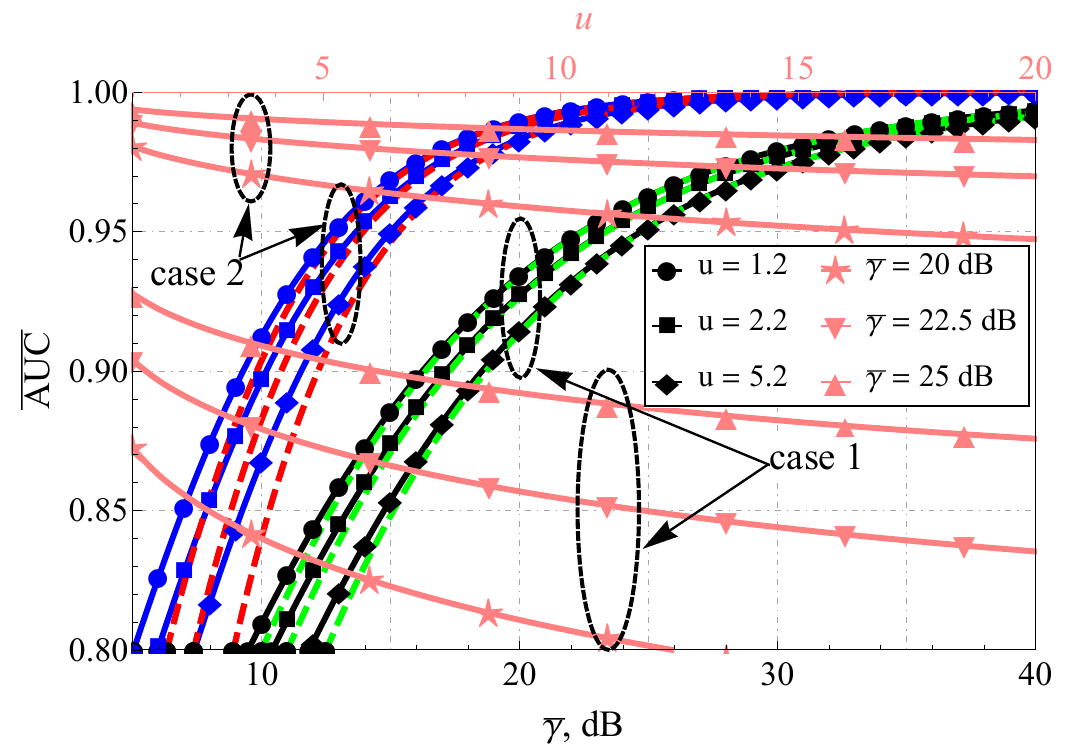
Figure 4. Average AUC comparison for Beaulieu-Xie shadowed model and various u : black lines (case 1) show m X = 0.5, m Y = 0.1, Ω X = − 1 dB, Ω Y = 1 dB, blue lines (case 2) show m X = 1, m Y = 1, Ω = − 1 dB, Ω = − 1 dB, dashed red and green lines—proposed approximations. X Y